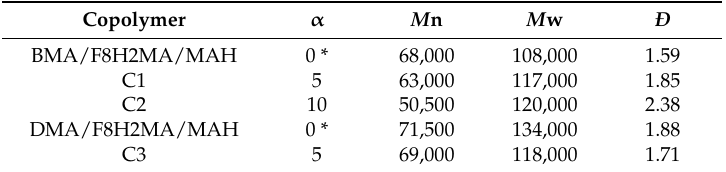
Table 10. Molecular weights of the copolymers for different value of excess α